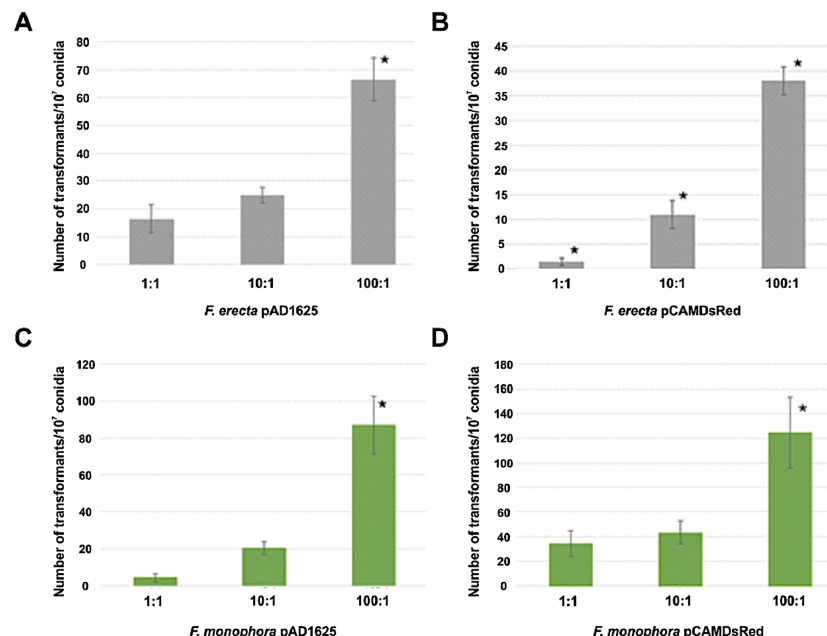
Figure 1. Number of transformants per 10 7 conidia obtained by AMT. Comparison of transformation efficiency between 1:1, 10:1 and 100:1 (bacteria:conidia) ratios of Fonsecaea erecta with pAD1625 ( A ) and pCAMDsRed ( B ), and Fonsecaea monophora with pAD1625 ( C ) and pCAMDsRed ( D ) plasmids. The statistical tests applied were one-way ANOVA and Tukey’s post-test. * indicates significant statistical di ff erence with 95% confidence.